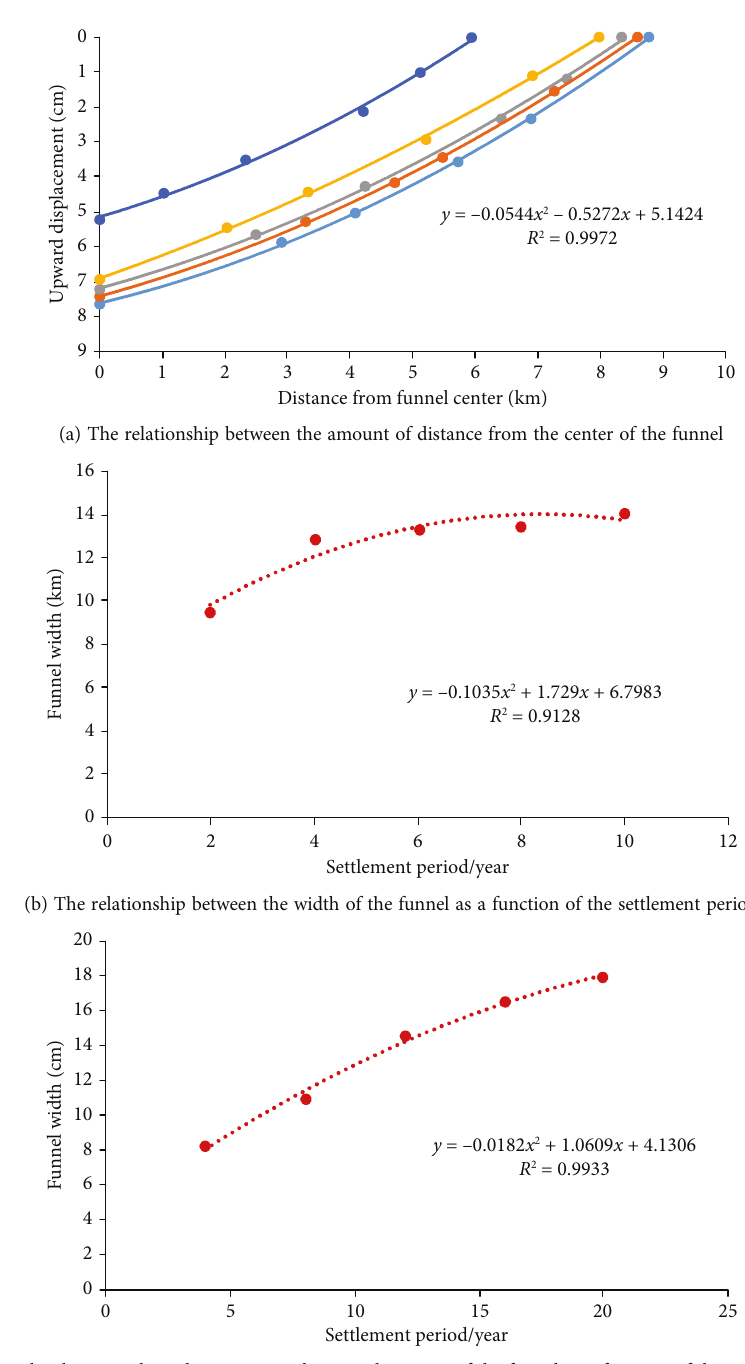
Figure 9: Curve relation of surface subsidence with